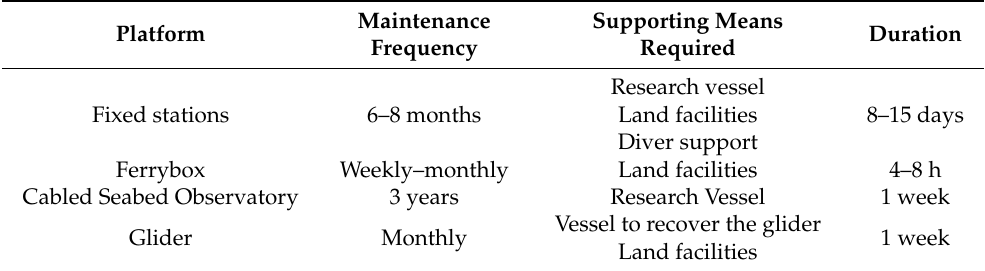
Table 3. The frequency of maintenance, the duration and the supporting means required per plat- form of the POSEIDON system.